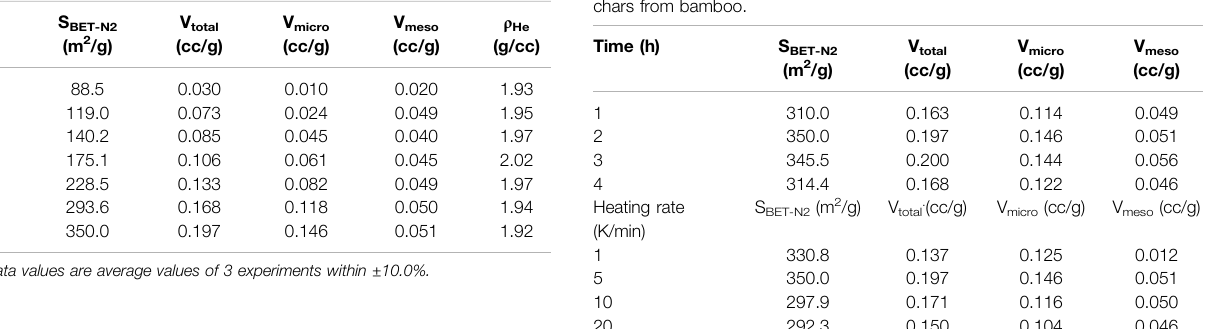
TABLE 3 | Effect of pyrolysis holding time on the elemental composition of chars from bamboo. Time (h) Yield (%) Elemental composition Ash (%)